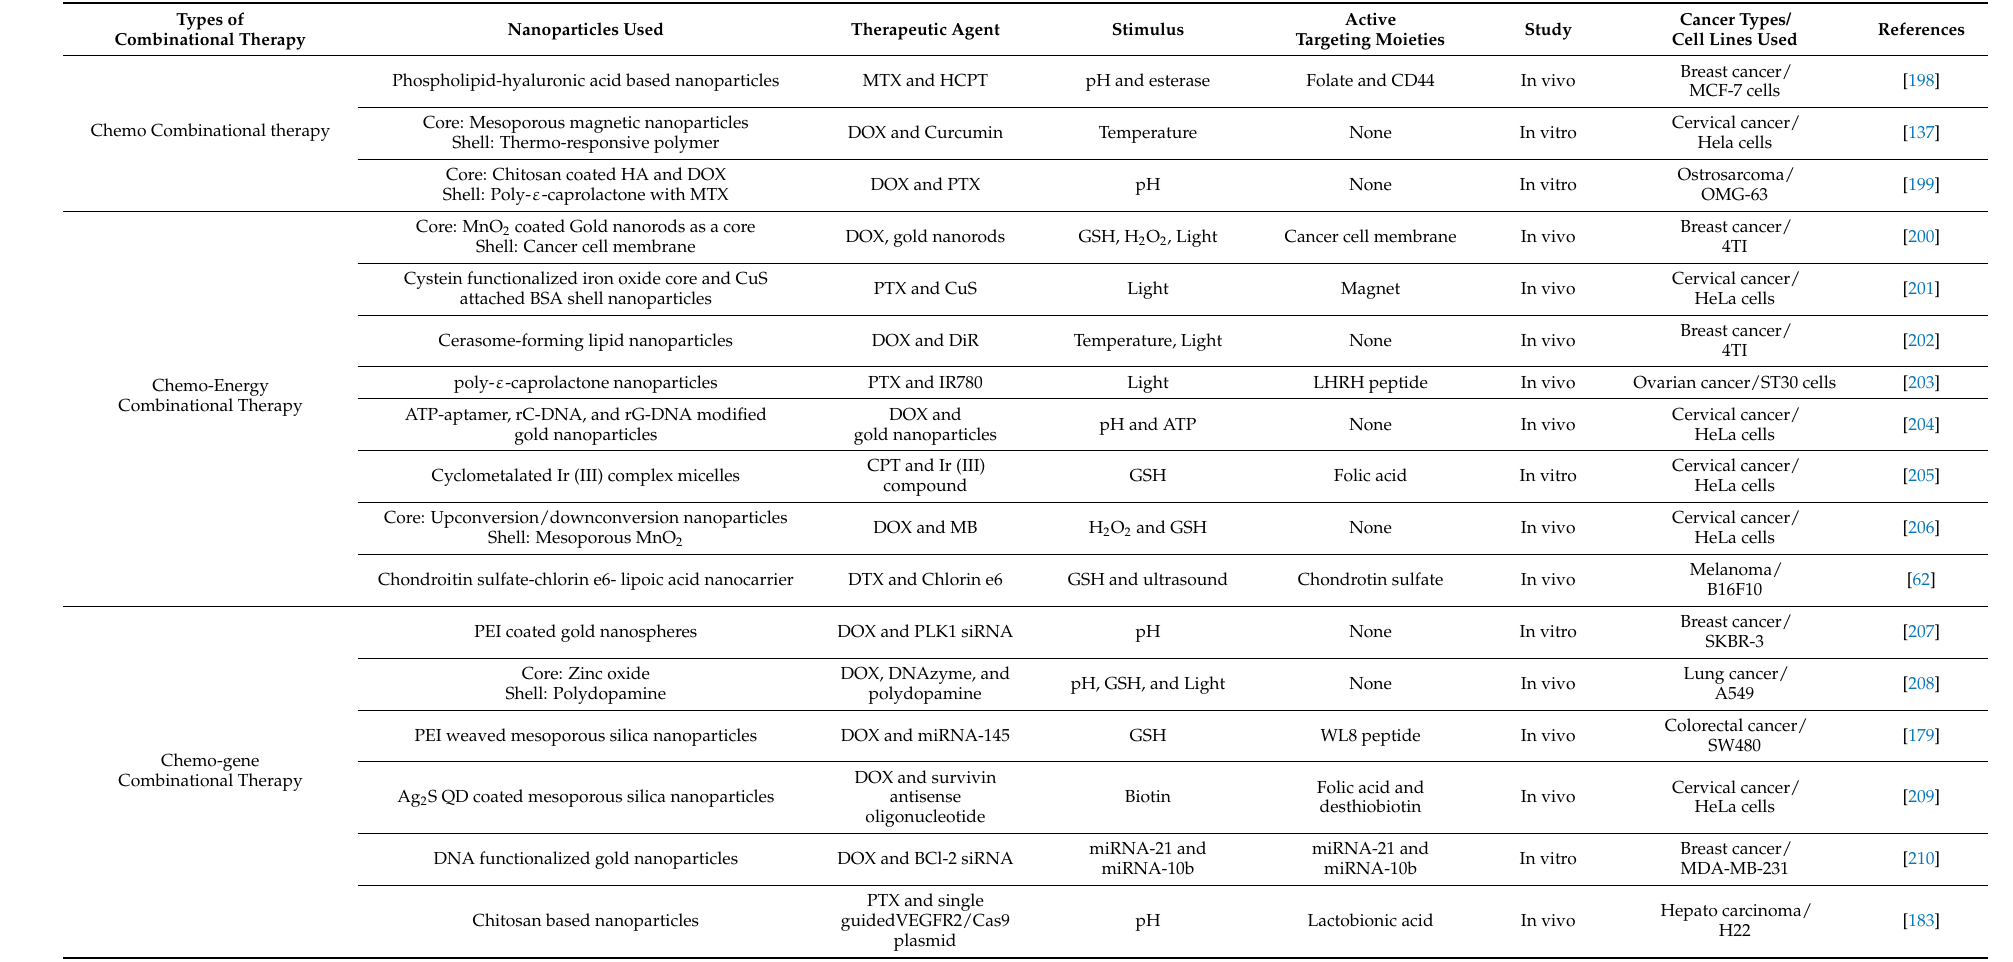
Table 1. Recent examples of smart nanoplatforms for combinational